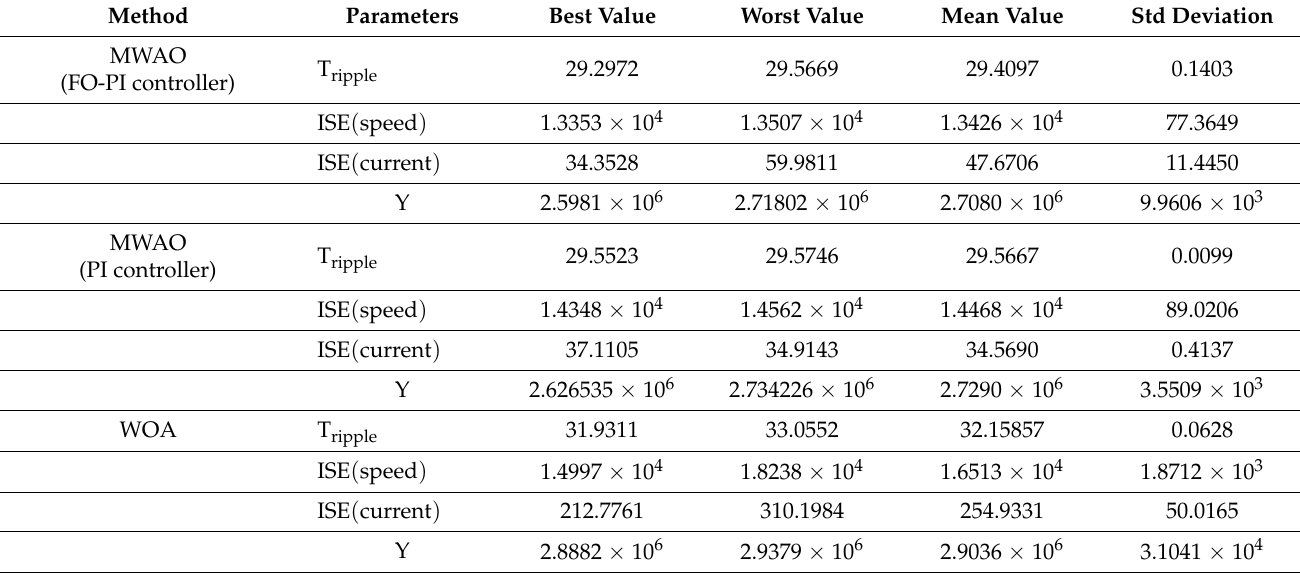
Table 9. Statistical execution of (PI/FO-PI) controller, commutation angle controller.